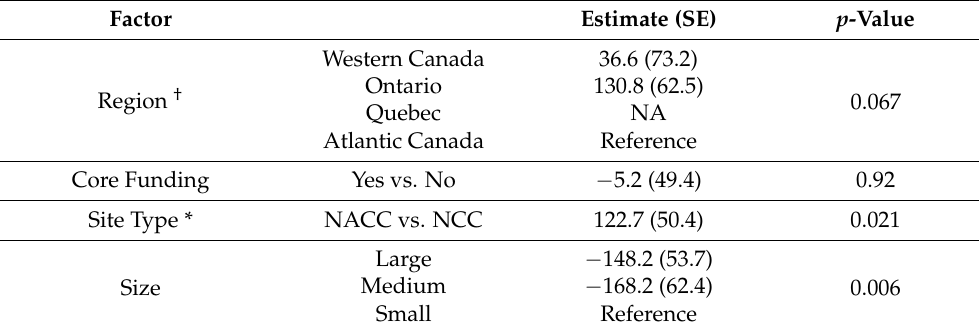
Table A2. Prognostic factors of change in accrual (repeated measures) % change—subgroup of